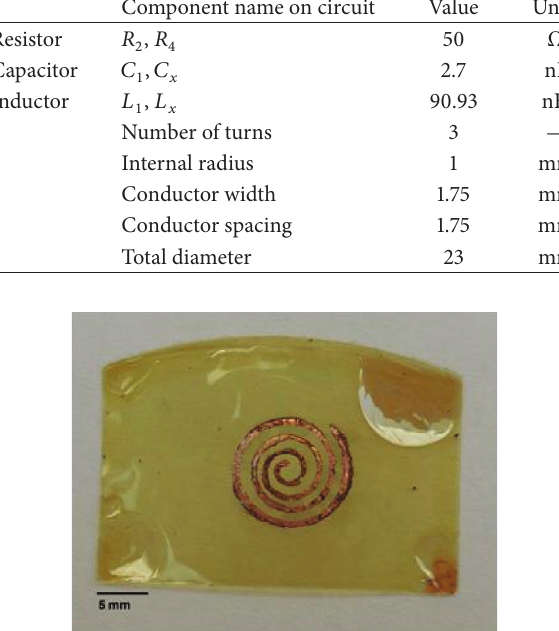
Figure 8: Copper coil with polyimide coating.